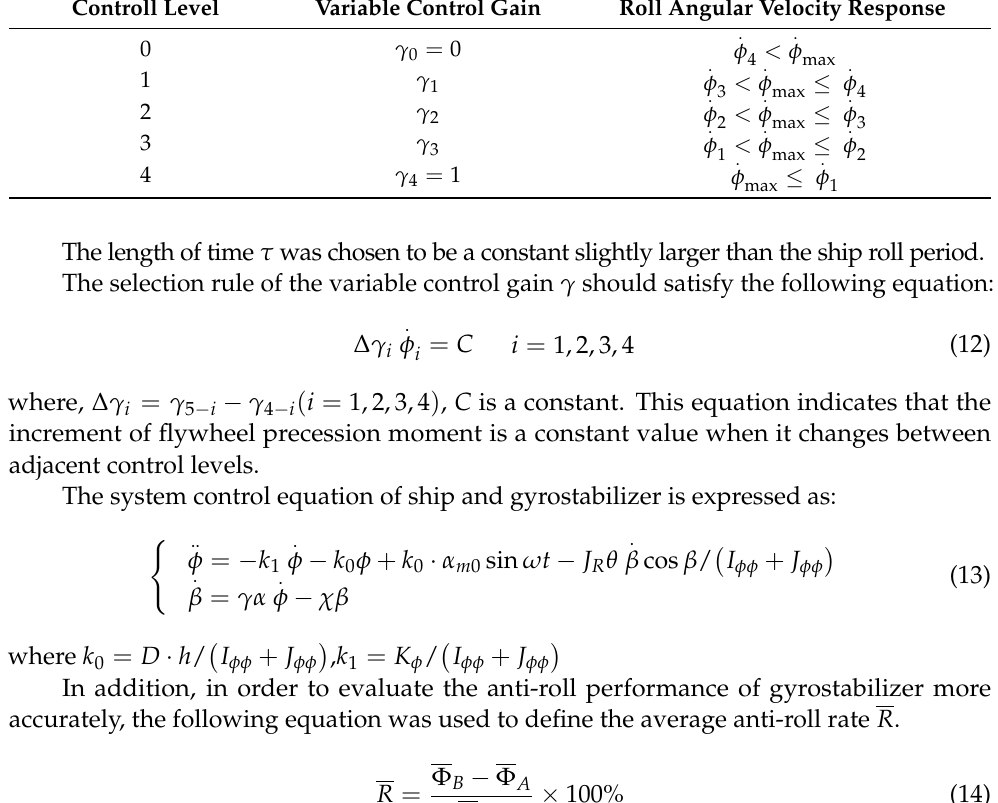
Table 3. Design Parameters of the variable gain controller. Controll